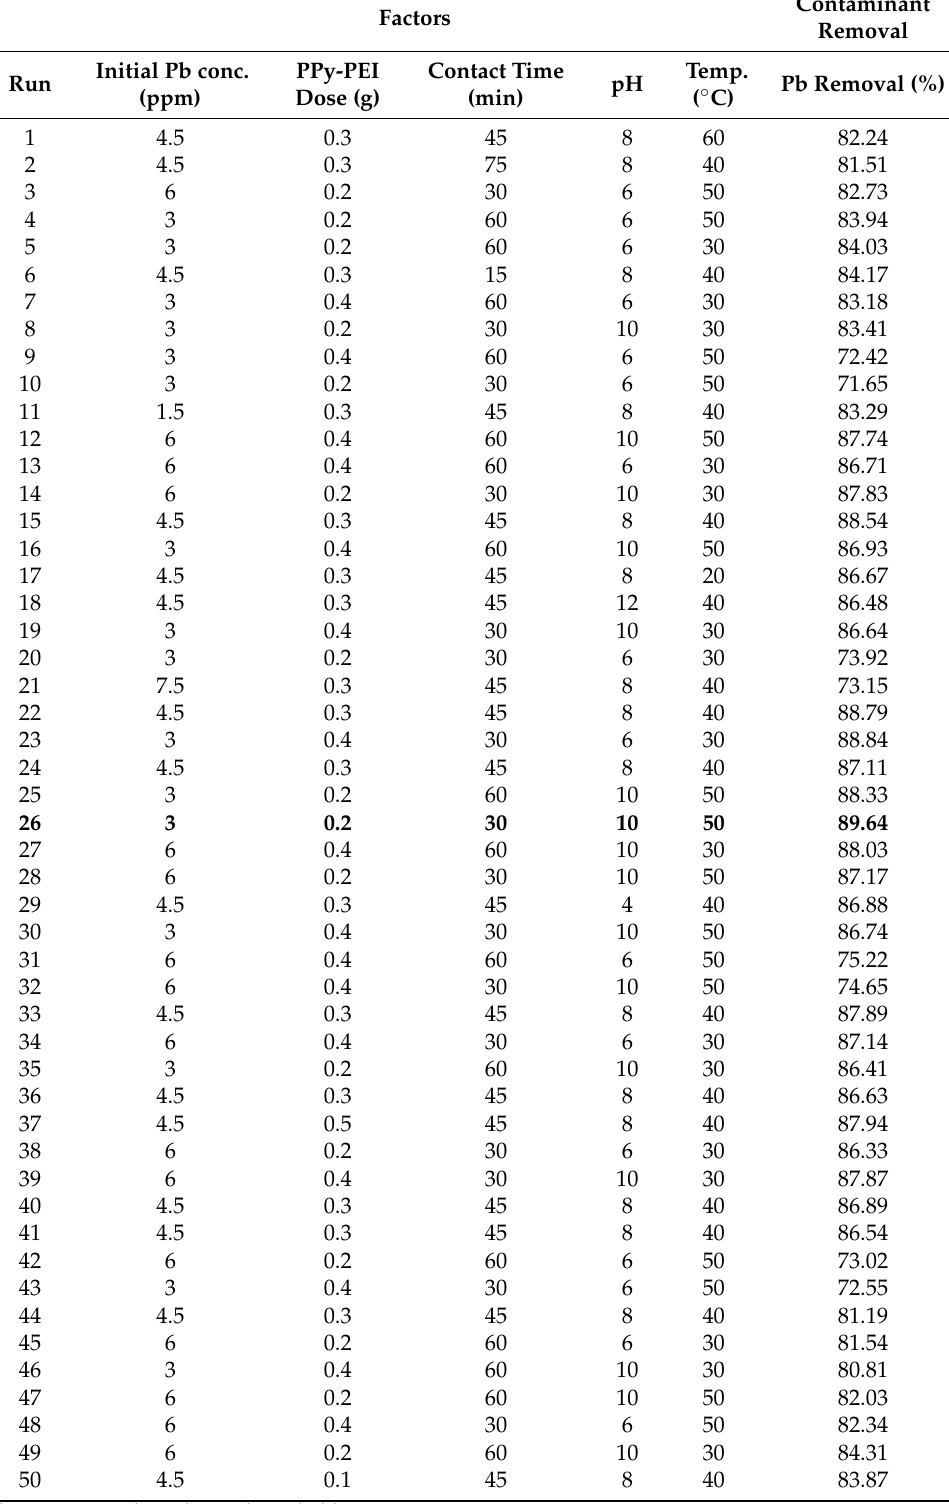
Table 2. Design matrix for Pb